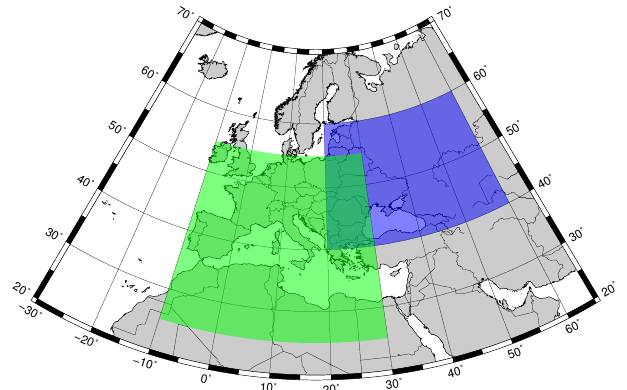
Figure 1. Target (grey) and analysis domains (blue for the Russian wildfires and heat wave case and green for the Saharan desert dust